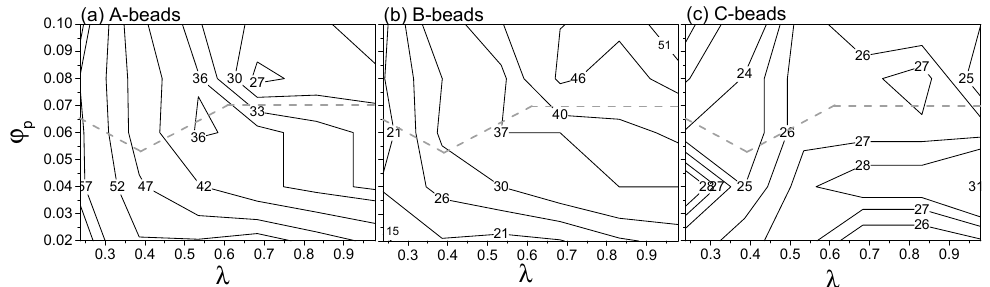
Figure 5. The percentage (%) of ( a ) A-; ( b ) B-; and ( c ) C-beads on the skins of aggregates (both inner- and outer-skins are included). The dashed line depicts the micelle-vesicle boundary based on the state diagram in Figure 2.